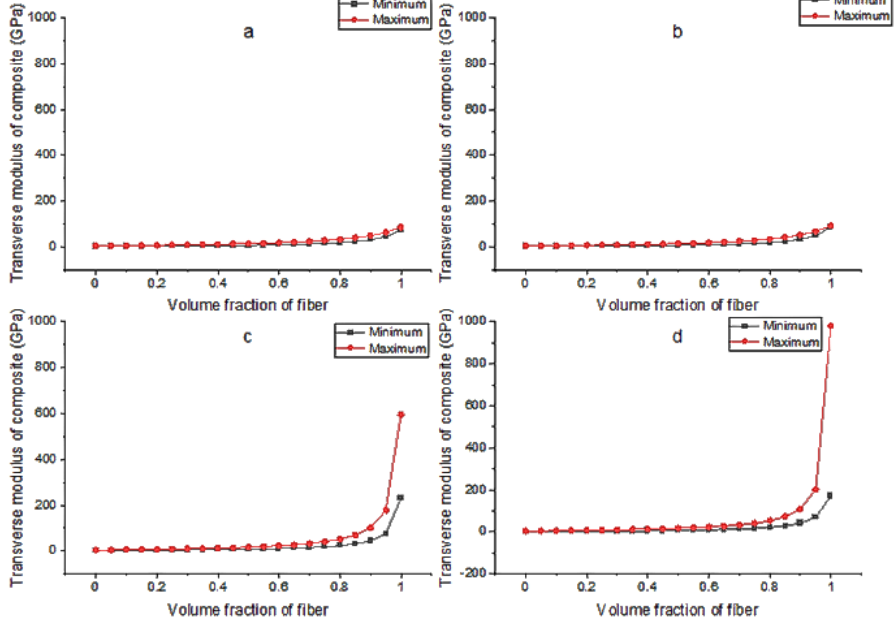
Figure A2. Depicts the variation in transverse modulus of ( a ) E-glass, ( b ) S-glass, ( c ) T300 carbon fiber and ( d ) AS carbon with volume of fiber. It can be seen that as the fiber ratio increases, the transverse modulus of the all the materials increases. It is also noted that at a fiber ratio of 1, the value of the transverse modulus is maximum; however, this cannot be achieved as there would be no matrix for